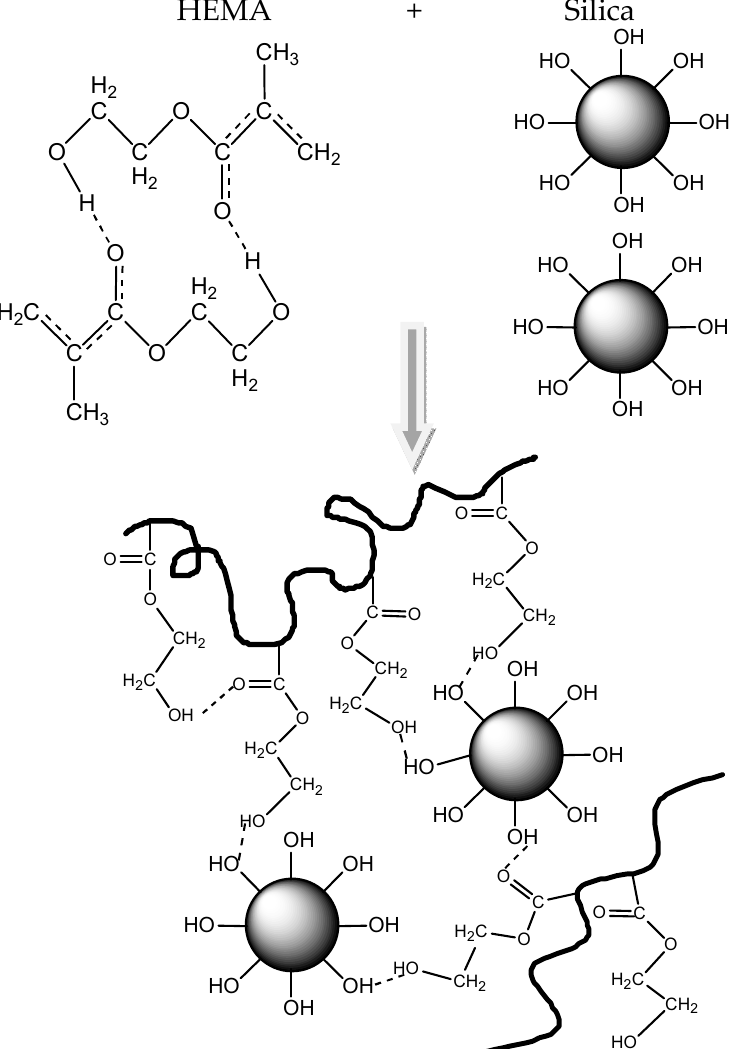
Scheme 3. Schematic illustration of the polymerization of HEMA to PHEMA in the presence of